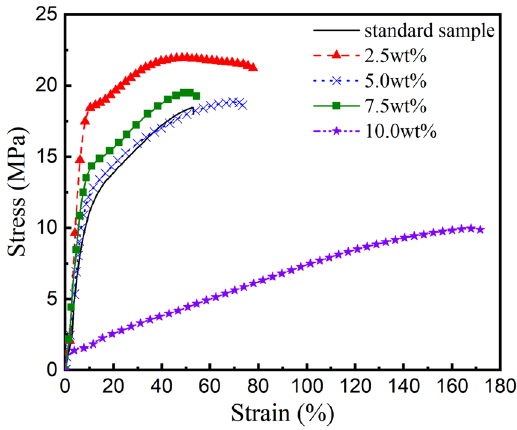
Figure 3: Plot of relative stress vs strain for corn starch modi fi ed specimens.